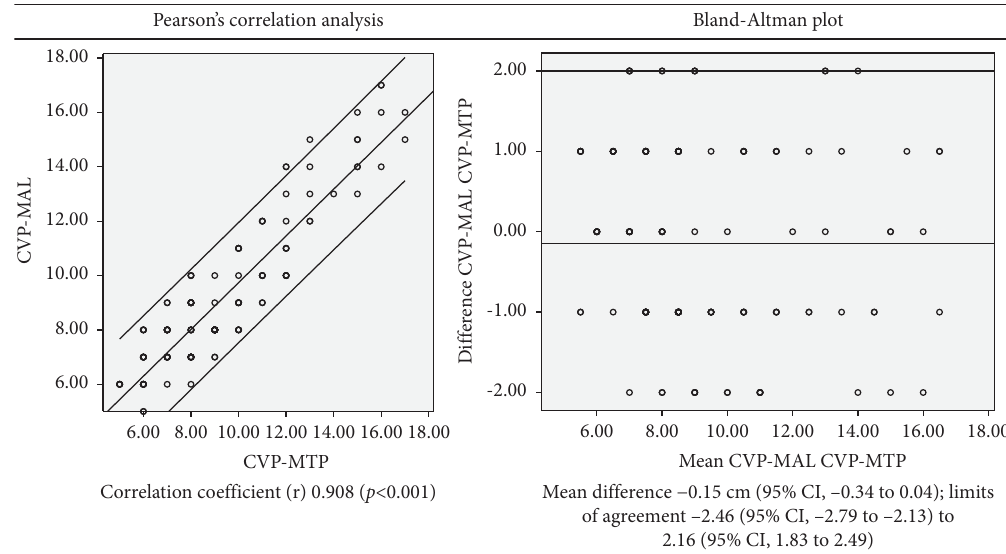
Figure 1: Pearson’s correlation and Bland–Altman plots between CVP-MAL and CVP-MTP of 150 subjects. CVP-MAL: central venous pressure (CVP) measured from the midaxillary line (MAL) at the fourth intercostal space; CVP-MTP: CVP measured from the midthoracic plane (MTP) at the anterior fourth intercostal space